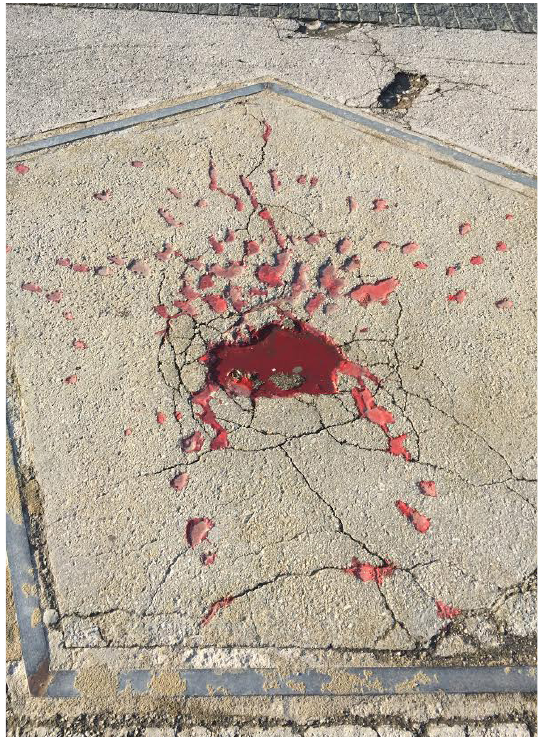
Fig. 1. A “Sarajevo rose” (photo: the